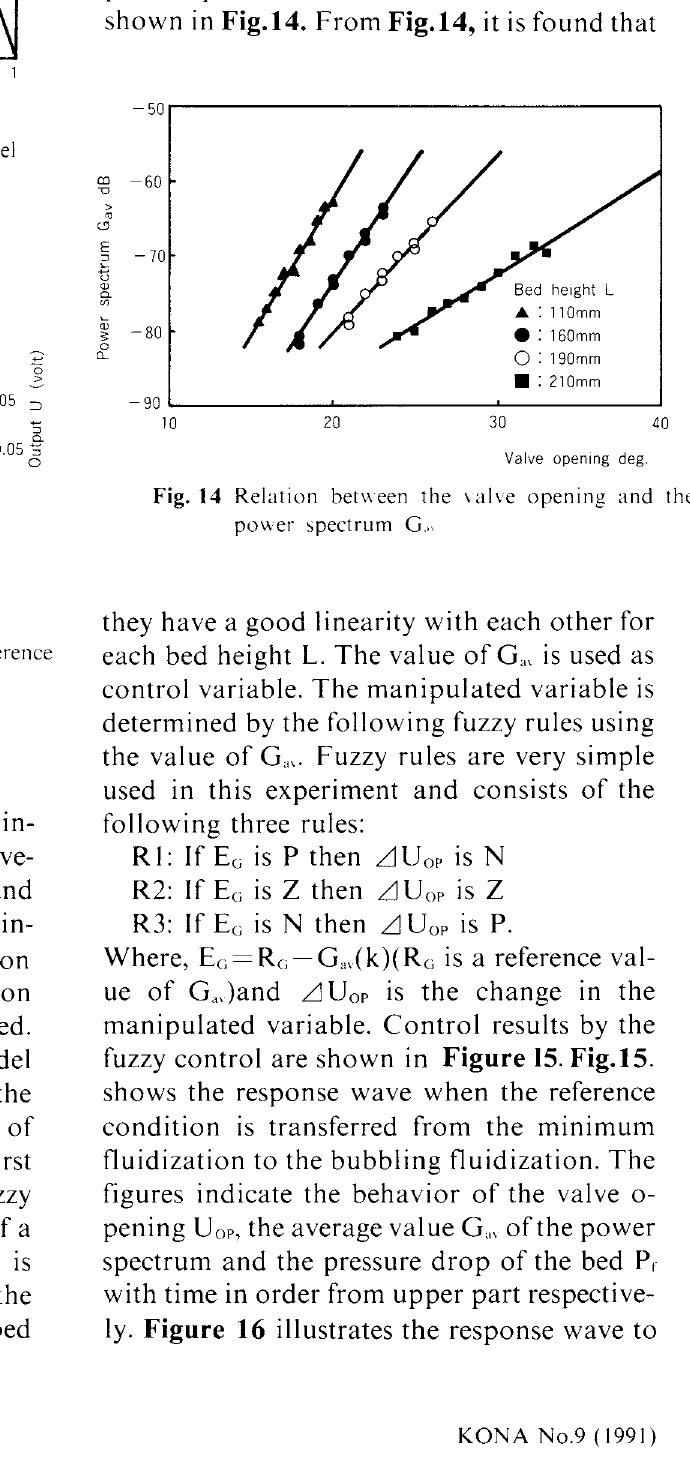
Fig. 12 Membership function u~ed in the le\el